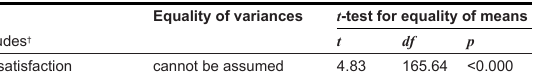
TABLE 10 Independence sample test: Job